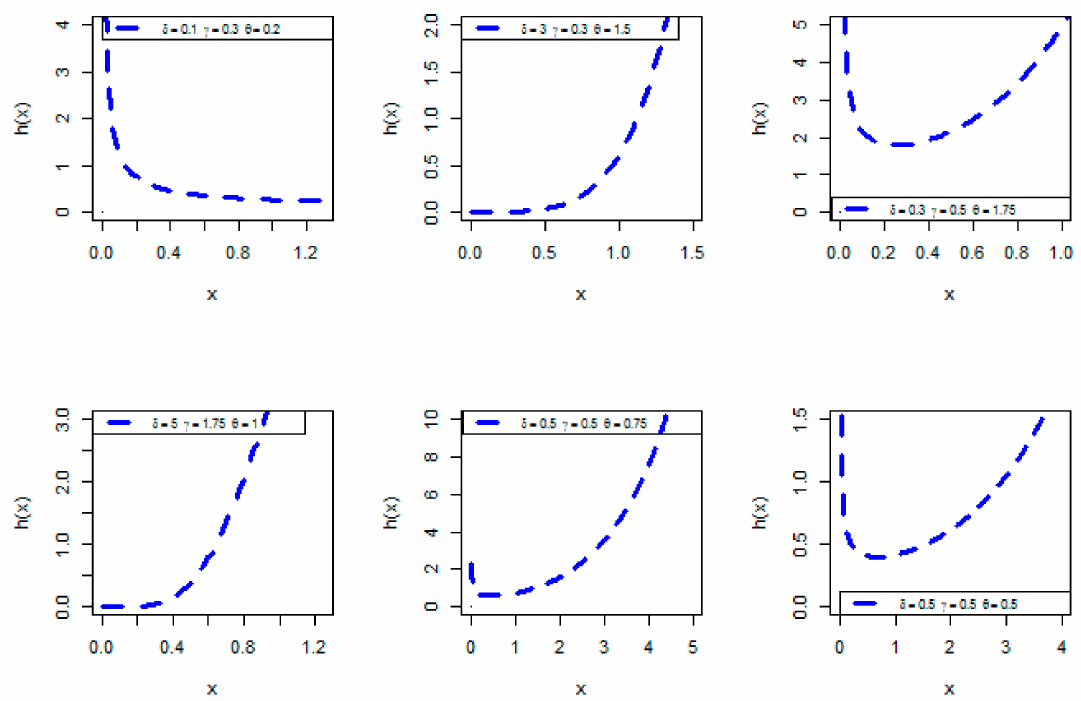
Figure 2. Plots of the OEHLE hazard rate function (HRF) for some parametric